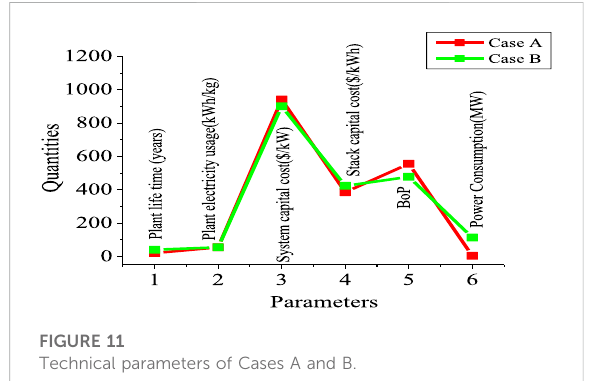
FIGURE 11 Technical parameters of Cases A and B.